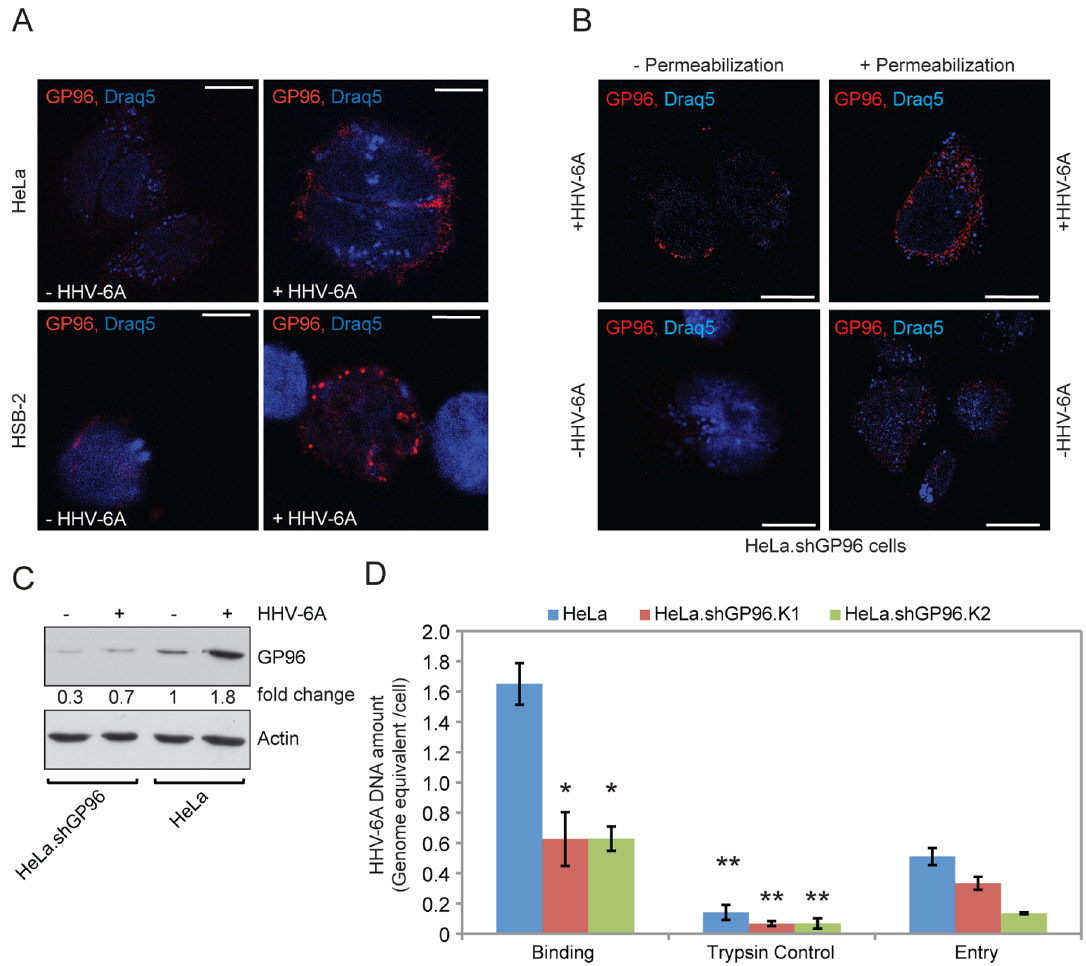
Figure 2. GP96 interacts with HHV-6. ( A ) Cell surface expression of GP96 increases in response to HHV-6 infection. HeLa and HSB-2 cells were infected with HHV-6A for one hour and analyzed by confocal laser microscopy. Draq5 staining was used to visualize nuclei. ( B ) GP96 expression is induced immediately after HHV-6A infection. HeLa cells carrying stable knock down of GP96 (HeLa.shGP96) were infected with HHV-6A for one hour. Non-infected cells served as control. Cell surface expression of GP96 was studied in non-permeabilized cells by immunofluorescence using a primary antibody against C- terminal end of GP96 and a Cy-3 conjugated secondary antibody. Total GP96 expression was studied in permeabilized cells. The scale bar represents 10 u ~ ( C ) Increase in total GP96 expression during HHV-6A infection. HeLa cells as well as HeLa.shGP96 cells were infected with HHV-6A for 48 h. Total GP96 expression was analyzed by Western blotting. Actin served as loading control. ( D ) Decrease in cell surface GP96 expression decreases HHV-6 binding and its subsequent entry. HeLa cells wildtype and GP96 knockdown cell lines (HeLa.shGP96 clone K1 and K2) were infected with HHV-6A to study viral binding and entry. Cells trypsinized to remove bound viral particles served as control. Cells were processed as described in Materials and Methods and viral DNA was quantified by qPCR. Data represent the mean ¡ SEM of three independent experiments. *, p # 0.05 and **, p # 0.005. Statistical analysis was based on the Student